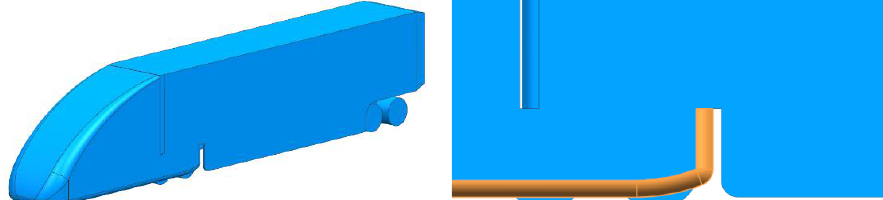
Fig. 18. Concept Two – Revision B – full view (left), modified tractor rear (right – highlighted in orange).